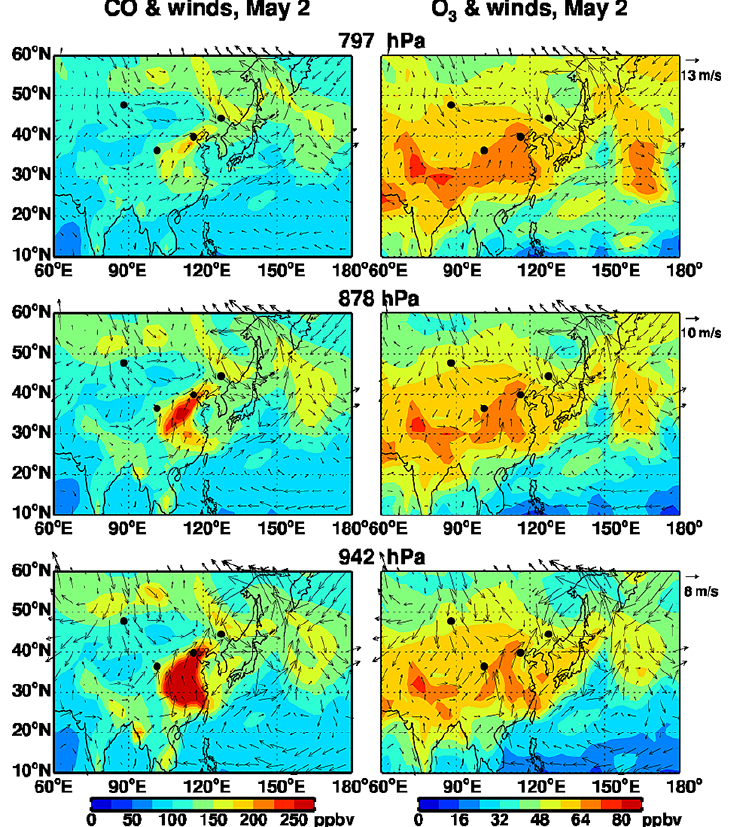
Figure 11. Average CO concentrations (ppbv, left panels) and O 3 concentrations (ppbv, right panels) in the lower troposphere (797hPa, top panels; 878hPa, middle panels; 942hPa bottom panels) over eastern Asia on 2 May 2005, as simulated by GEOS-Chem driven by the GEOS-4 meteorological fields. Dots denote the locations of four ozonesonde stations shown in Fig. 1. Arrows are wind vectors. Note the different arrow scales for wind vectors at different